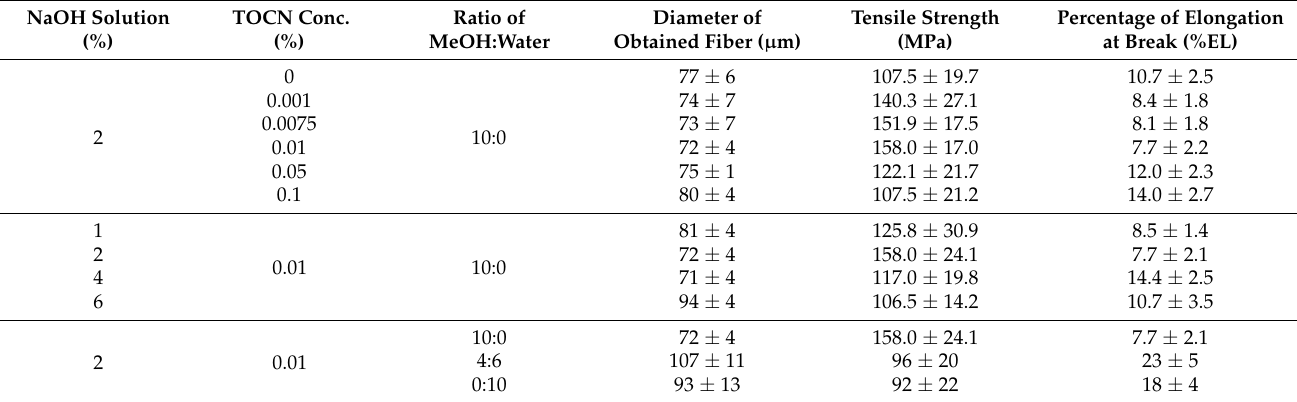
Figure 3. Coagulation of TOCN during fiber production using different concentrations of TOCN: ( a ) 0.01%, ( b ) 0.05%, and ( c ) 0.1%. The fiber diameters of CS/TOCN composite fiber (change in TOCN concentration, NaOH concentration, and washing conditions) are shown in Table 2. The fiber diameter of pristine CS fibers was 77 ± 6 µ m. For CS/TOCN composite fibers, the diameter tended to be smaller, and the fiber diameter at 0.01% TOCN was 72 ± 4 µ m. These results can be attributed to contraction owing to the attachment of TOCN to CS via electrostatic interaction. By contrast, the fibers gradually thicken at concentrations higher than 0.01%. The fiber diameter at 0.1% TOCN was 80 ± 4 µ m; this increased thickness of the fiber can be attributed to the excessive adhesion of TOCN. Table 2. Physical and mechanical properties of various types of